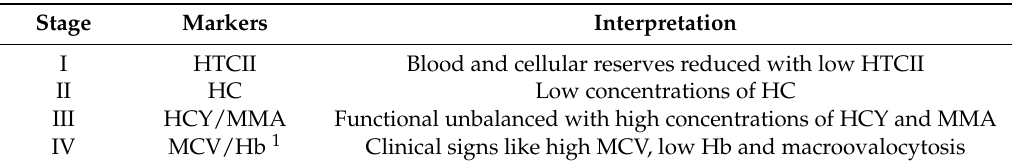
Table 4. Herbert’s stratification for vitamin B12 deficiency